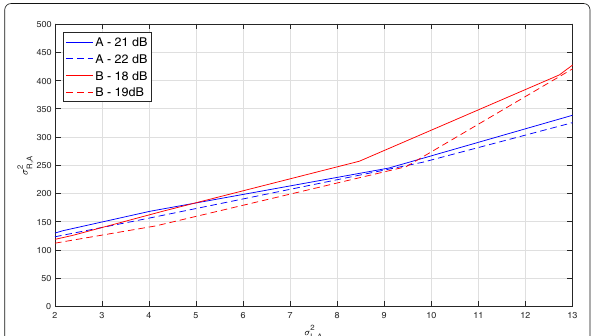
Fig. 3 σ 2 versus σ 2 curves obtained by Monte Carlo simulations for R , A L , A two different RCM-LDGM codes. A (fast fading Rayleigh channel) and B (AWGN channel) denote the codes of Tables 3 and 1 for p 0 = 0.8,